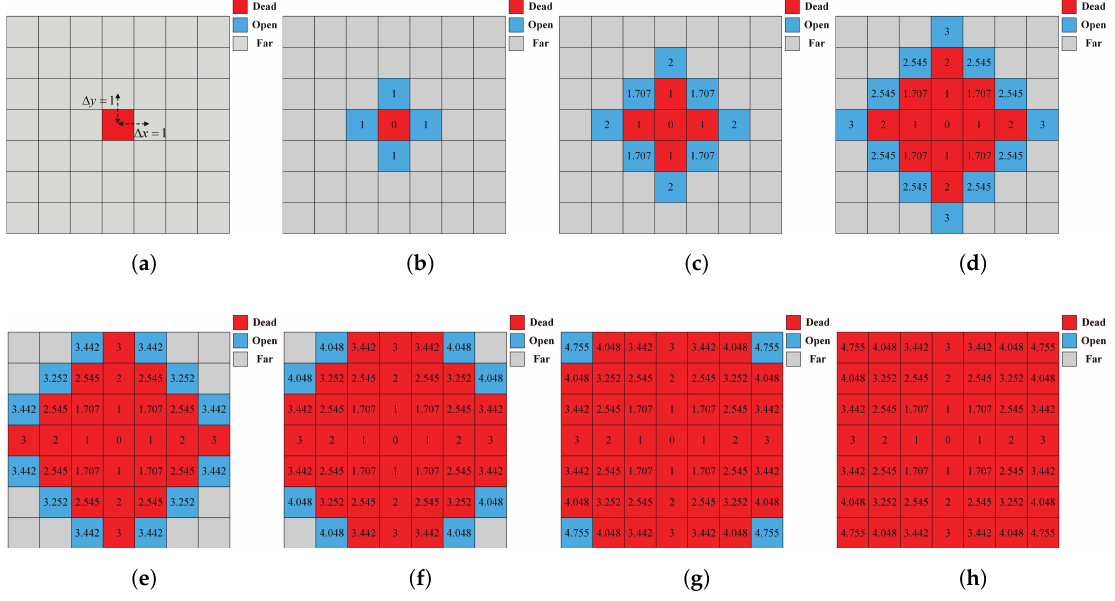
Figure 3. The updating process when using the fast marching method (FMM). ( a ) Initial state; ( b ) Iteration 1; ( c ) Iteration 5; ( d ) Iteration 13; ( e ) Iteration 25; ( f ) Iteration 37; ( g ) Iteration 45; ( h ) Iteration